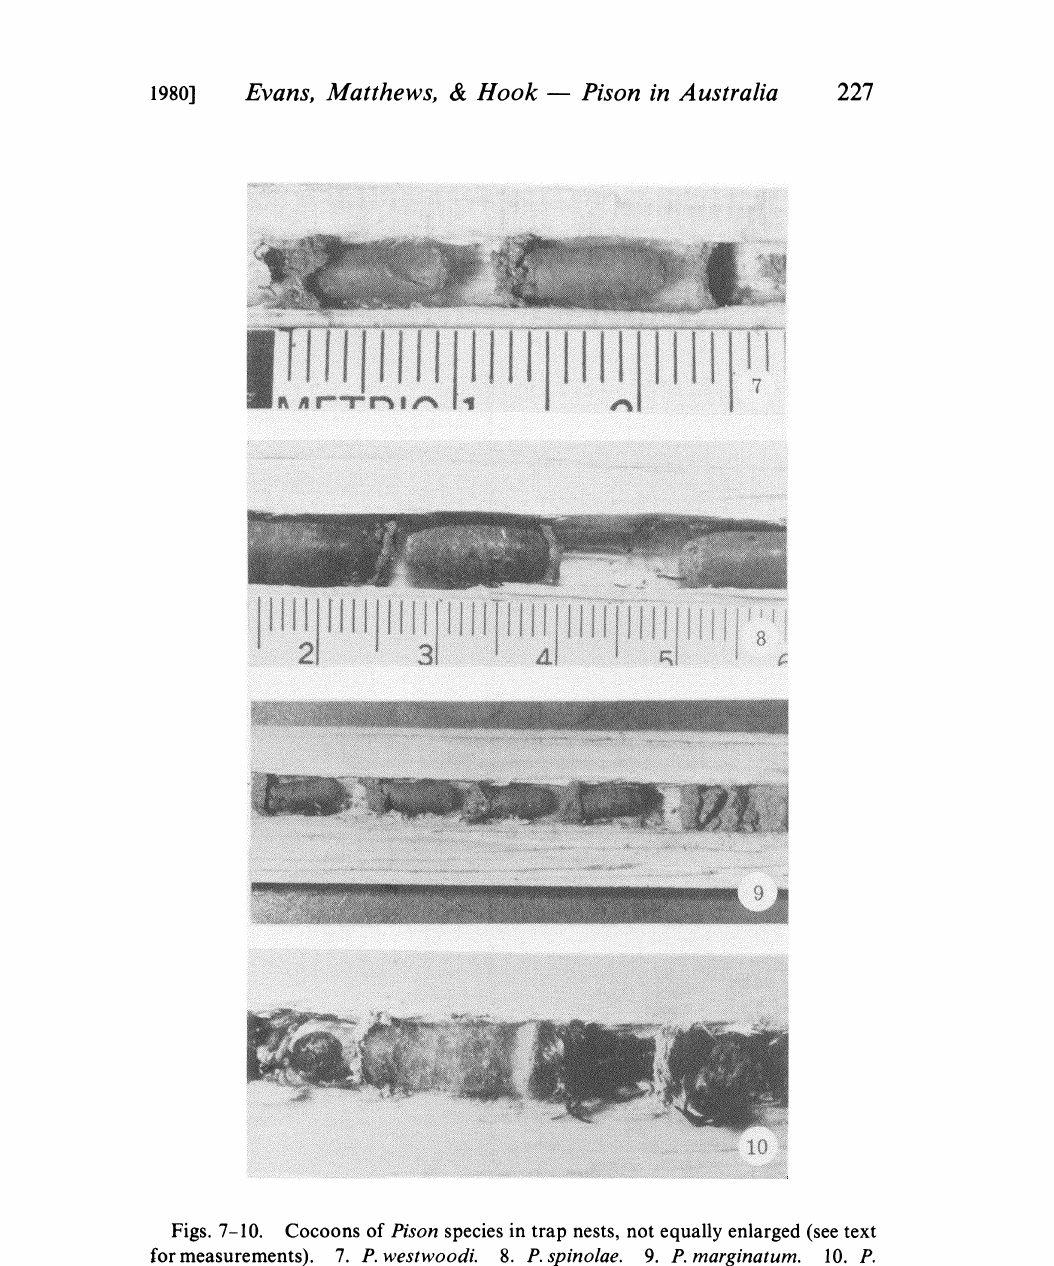
Figs. 7-10. Cocoons of Pison species in trap nests, not equally enlarged (see text for measurements). 7. P. westwoodi. 8. P. spinolae. 9. P. marginatum. 10. P. species near